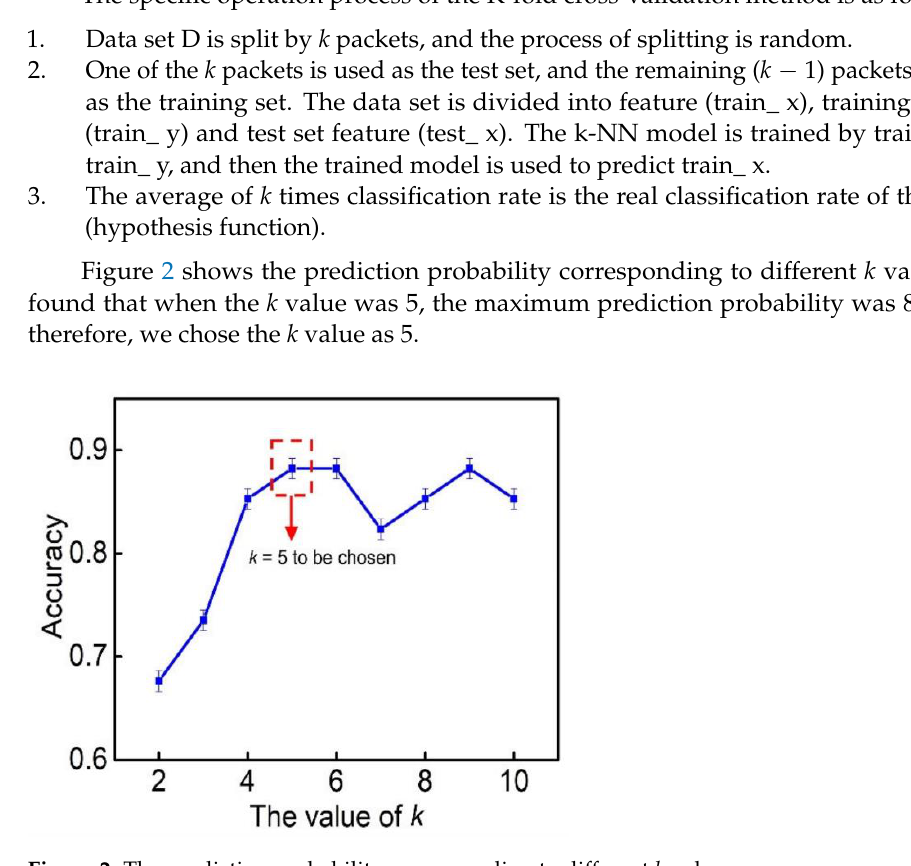
Figure 2. The prediction probability corresponding to different k values.